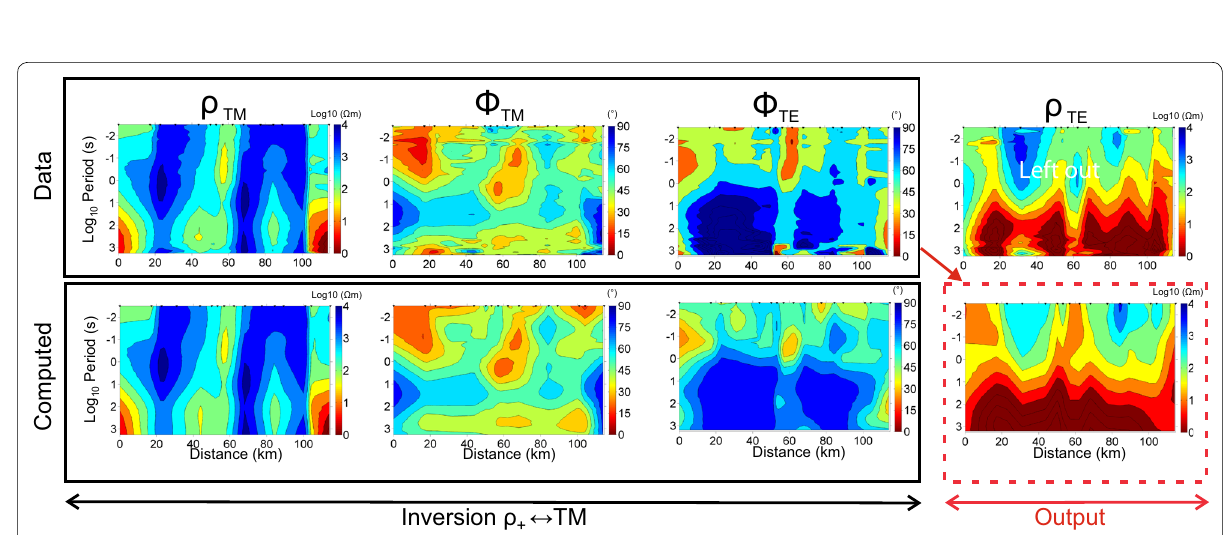
Fig. 7 Fit to the data for the invariant ρ assumed as the TM mode. The upper images are the data pseudo‑sections and the ones below are the + corresponding responses of the model. Notice that the pseudo‑sections of the TE apparent resistivity look more alike than in the previous three cases. The other three pairs indicate a good fit to the data. The TE apparent resistivity was not part of the inversion